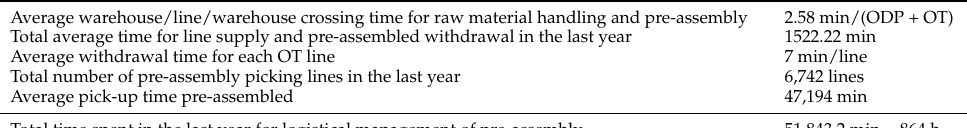
Table 3. Main activities connected to the launch of a production order from a logistic perspective. Average warehouse/line/warehouse crossing time for raw material handling and pre-assembly